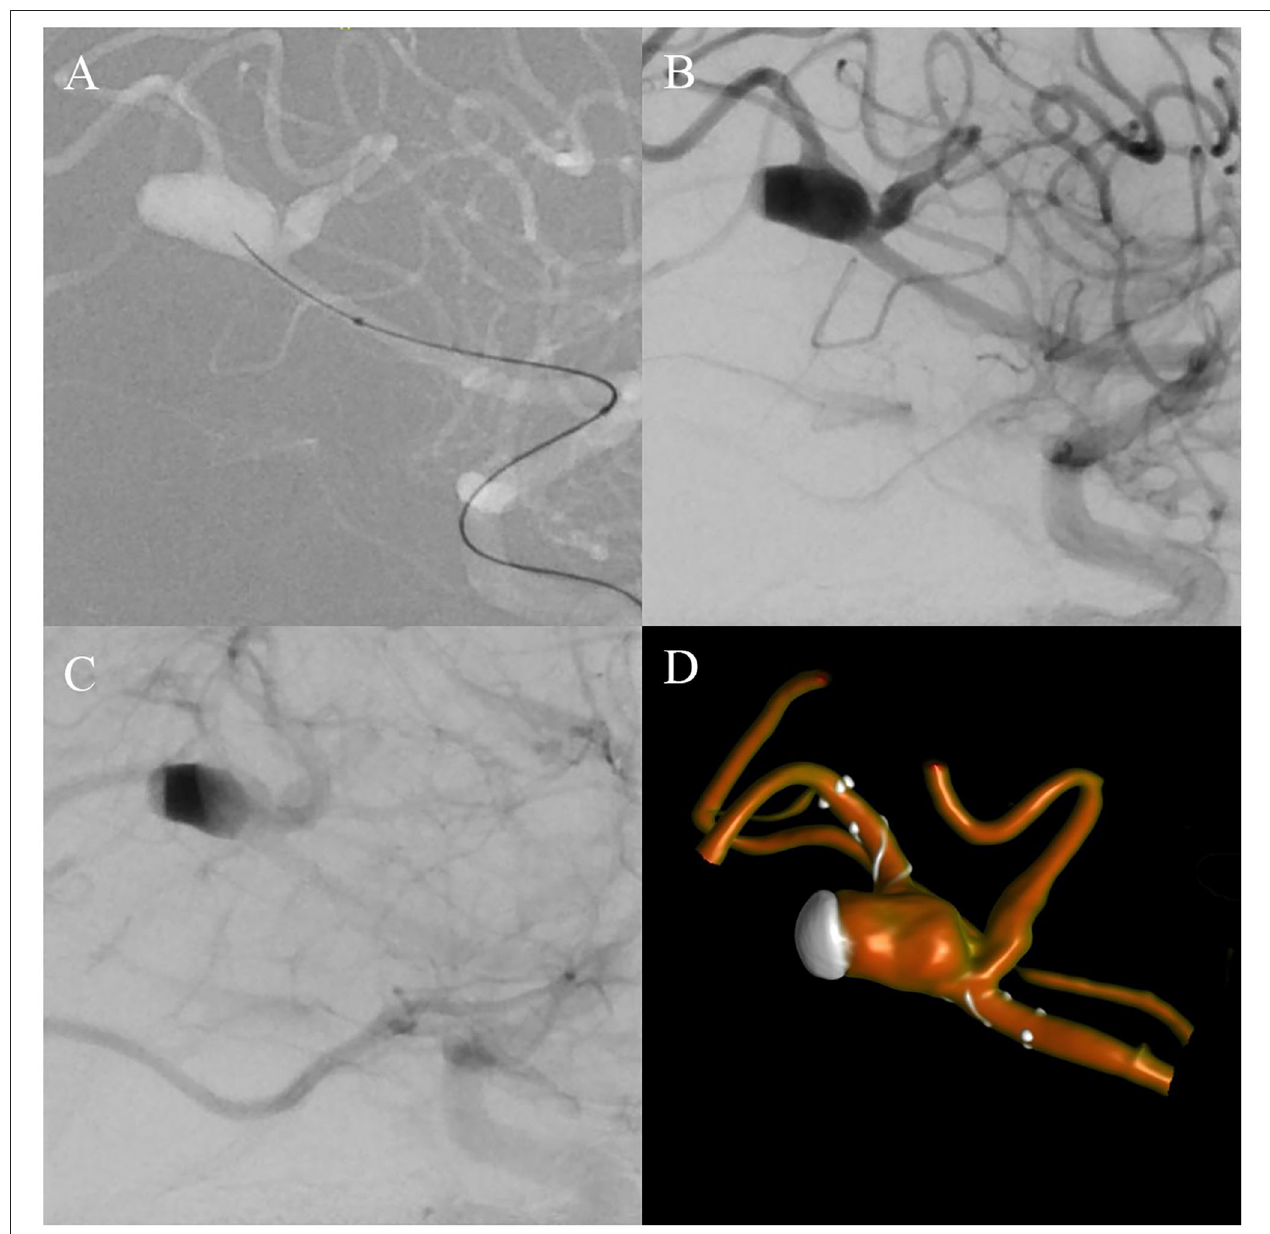
FIGURE 2 | Intra-interventional cerebral angiograms: (A) Lateral working projection during navigation of the microcatheter and microwire toward the aneurysm. (B) Directly after implantation of the flow diverter, contrast media stasis can be seen at the dome of the aneurysm as a gray, subtracted cap in the arterial phase. (C) In the venous phase, additional stasis in the majority of the aneurysm sack is depicted as a black band. (D) Postinterventional three-dimensional VRT showing the positioning of the flow diverter in relation to the aneurysm and marked stasis of contrast medium at the dome of the